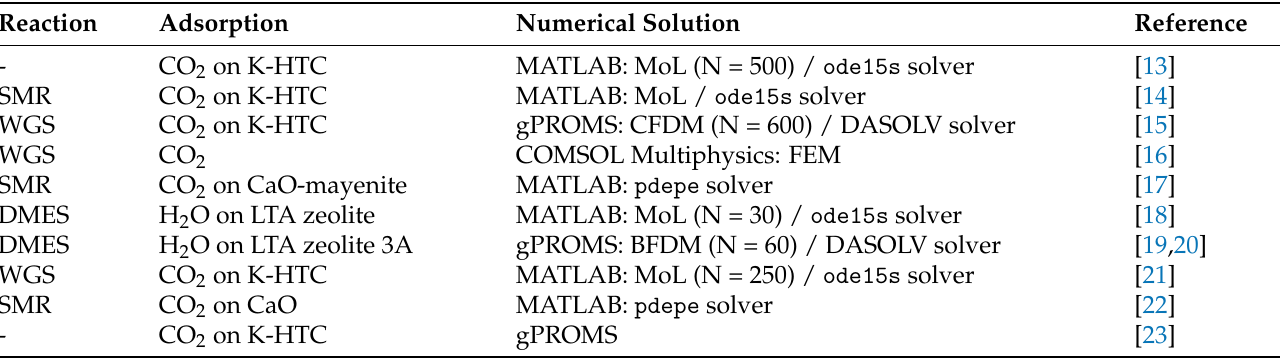
Table 1. Overview of selected studies employing different numerical methods for solving (reactive) adsorption